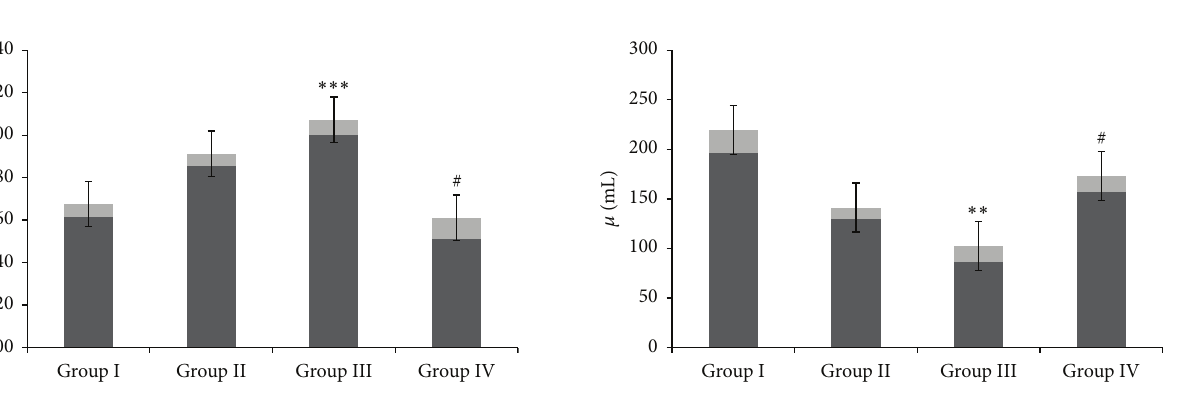
Figure 2: Effect of camel milk and gentamicin on SOD enzymes. Effect of CM intake and GM on renal SOD activity. Values are expressed as mean ± SEM ( 𝑛 = 6 ). ∗∗ 𝑃 < 0.01 shows significant difference in group III when compared with group I. # 𝑃 < 0.01